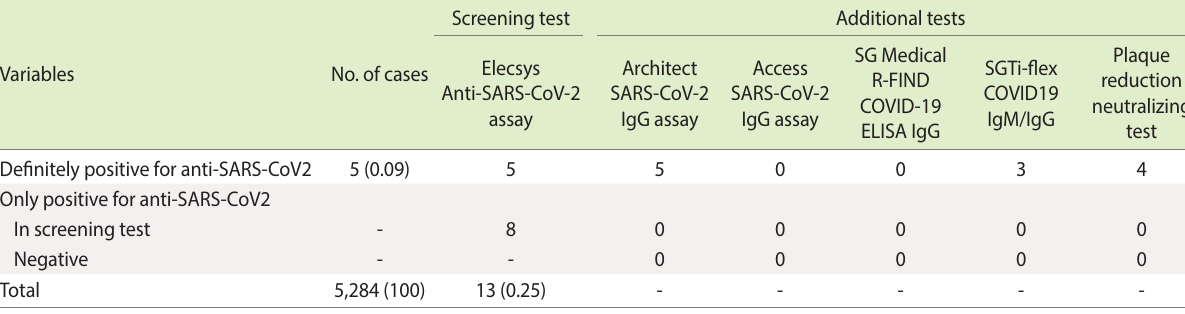
Table 2. Seroprevalence of SARS-CoV-2 antibodies 1